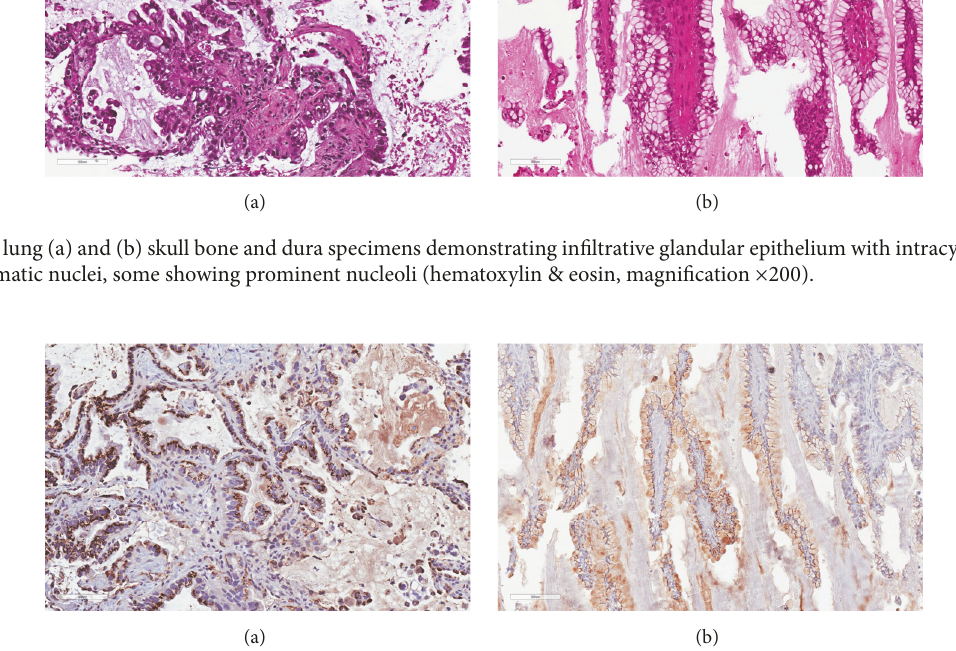
Figure 5: Tumor cells are positive for Napsin A staining in (a) lung and (b) skull bone and dura specimens (immunohistochemistry, magnification ×